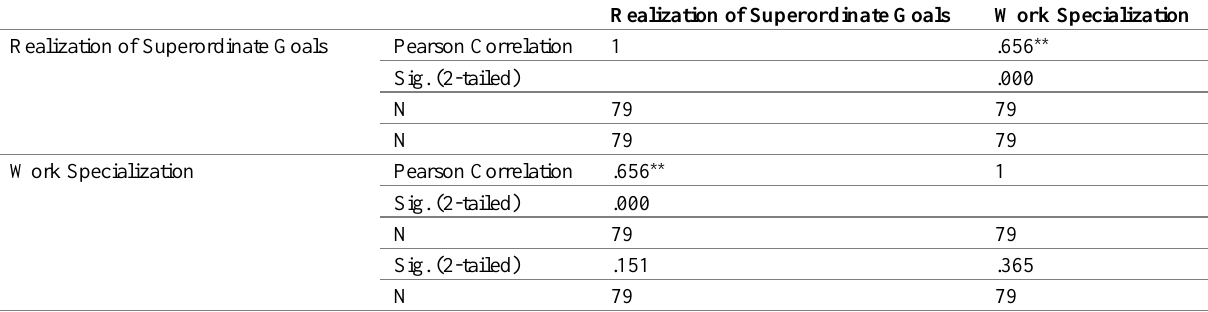
Table 5: Correlation Test